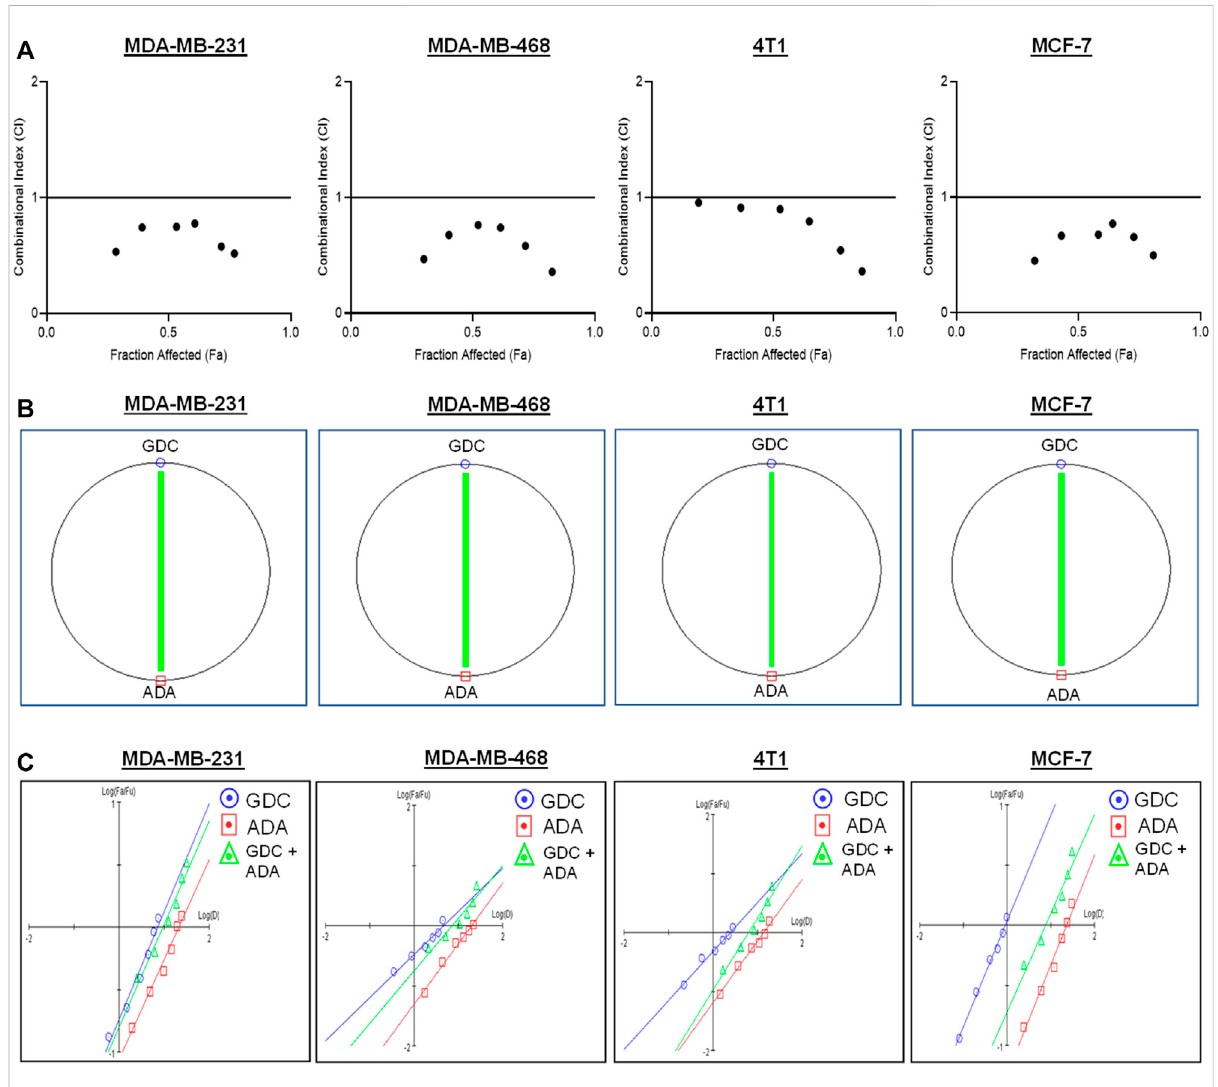
FIGURE 2 Adapalene andGDC showsynergisticpharmacodynamicinteractionsininhibitingthegrowthofTNBCcells (A) .CombinationIndex(CI)plotsof MDA-MB-231, MDA-MB-468, 4T1, and MCF-7 cells. The CI plots showed signi fi cant synergism between ADA and GDC in TNBC cells (B) . Polygonograms of MDA-MB-231, MDA-MB-468, 4T1, and MCF-7 cells (C) . Median Plots of MDA-MB-231, MDA-MB-468, 4T1, and MCF-7